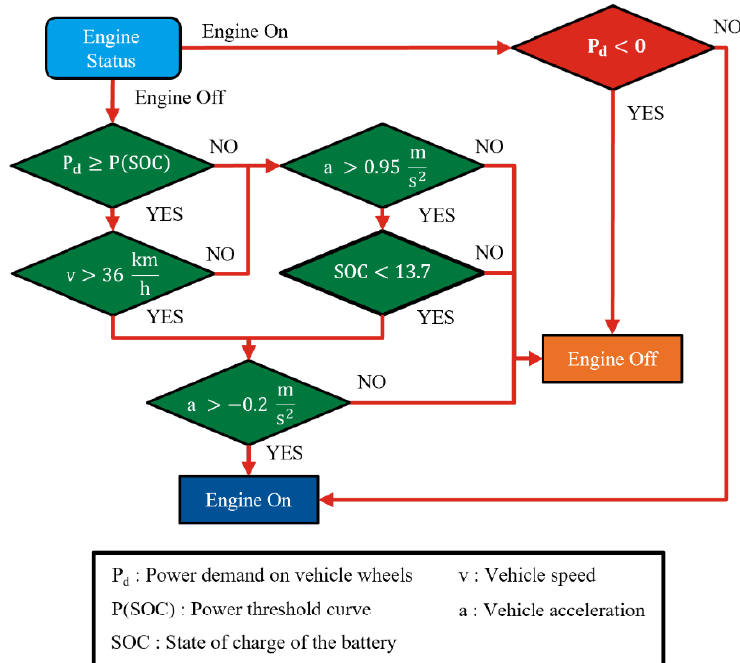
Figure 1. Stock rule-based algorithm extracted from experimental evidence .